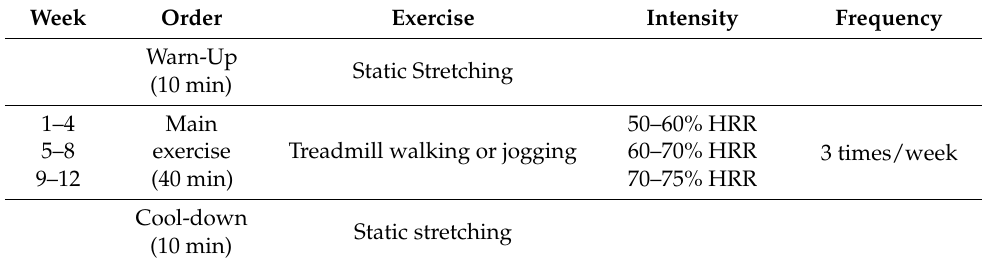
Table 3. Aerobic exercise program.